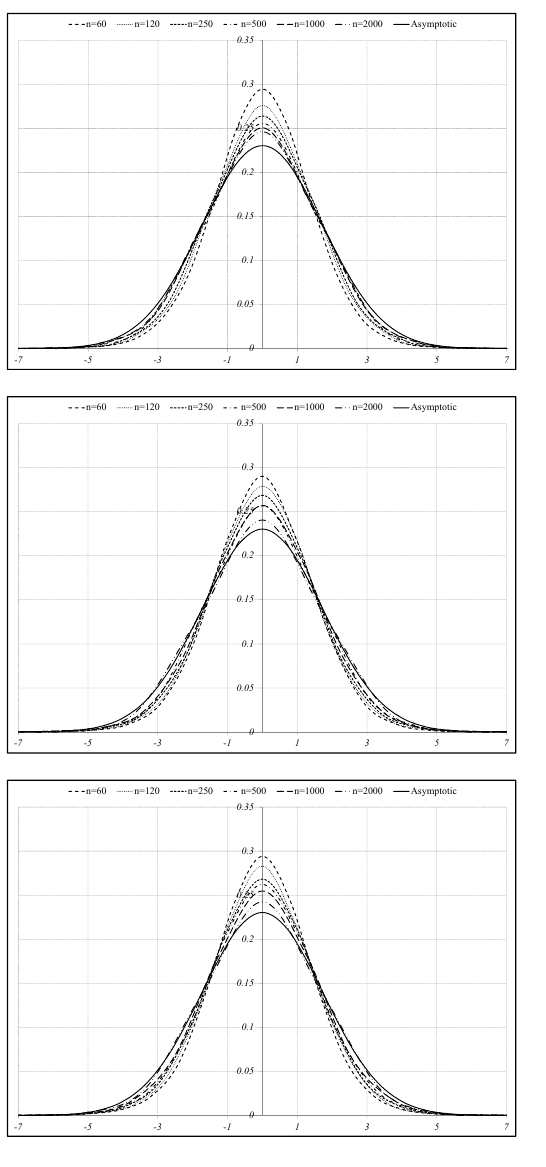
Figure 3. Kernel density estimators for n ∈ { 60, 120, 250, 500, 1000, 2000 } and the asymptotic density of the standardized estimator for the beta coefficient in the case of the k = 5 ( top left ), k = 10 ( top right ), k = 15 ( middle left ), k = 20 ( middle right ), k = 25 ( bottom left ), and k = 30 ( bottom right ) dimensional equally-weighted portfolio. The asset returns are drawn from the multivariate t -distribution with 5 degrees of